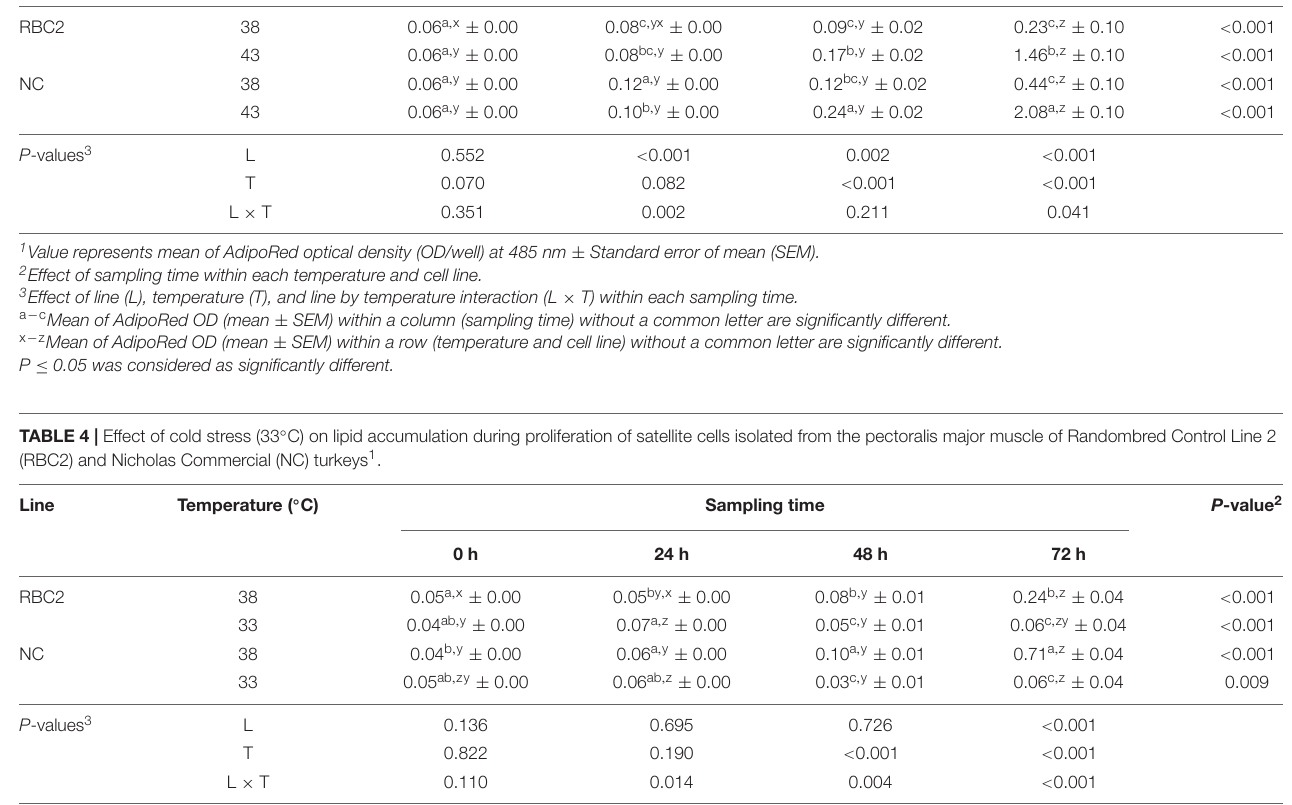
Figure 1C ). Both the RBC2 (1.53-fold, P < 0.001) and NC (1.86-fold, P < 0.001) lines showed a lower expression of PPAR γ in the 43 ◦ → 43 ◦ C group than the 38 ◦ → 38 ◦ C group ( Figure 1C ). With the cold stress, PPAR γ expression was upregulated in both the RBC2 (1.69-fold, P = 0.002) and NC (1.57-fold, P = 0.003) lines in the 38 ◦ → 33 ◦ C group than the 38 ◦ → 38 ◦ C group ( Figure 1D ). Higher expression of PPAR γ occurred only in the RBC2 line SCs in the 33 ◦ → 38 ◦ C (1.66-fold, P = 0.002) and 33 ◦ → 33 ◦ C (2.91-fold, P < 0.001) groups than the 38 ◦ → 38 ◦ C group at 48 h of differentiation ( Figure 1D ). Interaction effect between temperature and cell line was significant among the cold treatment groups ( P < 0.001, Figure 1D